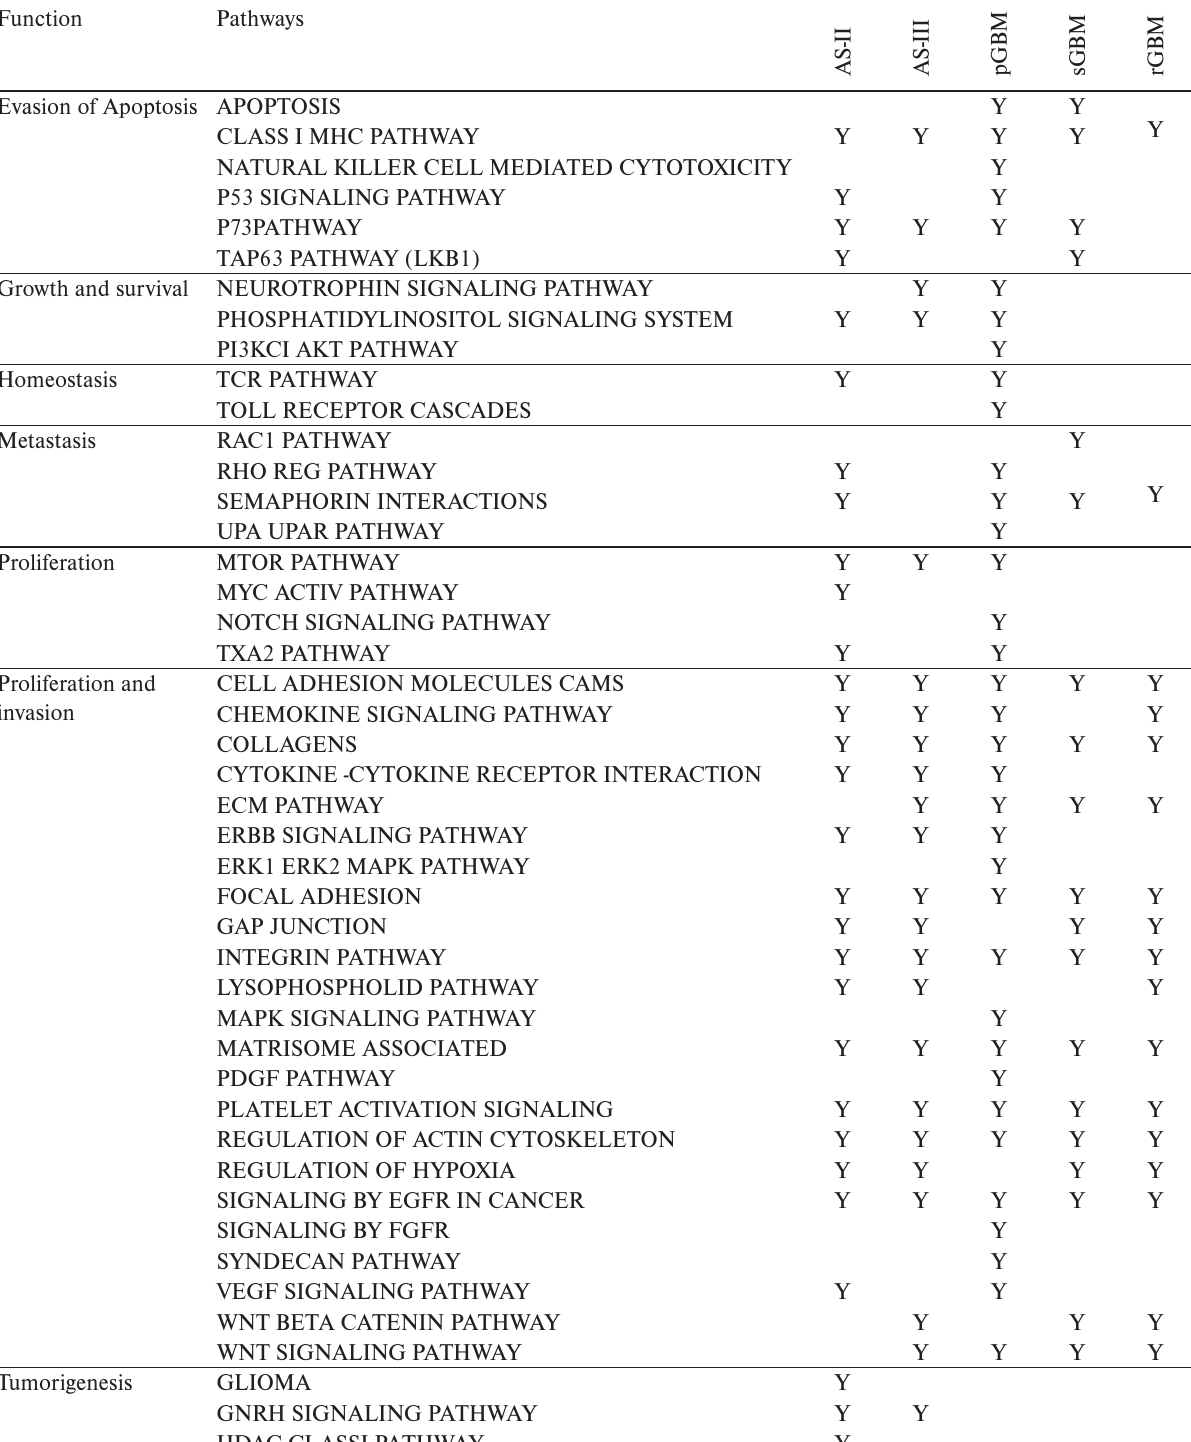
Table 3. Pathways implicated in astrocytoma grade II –